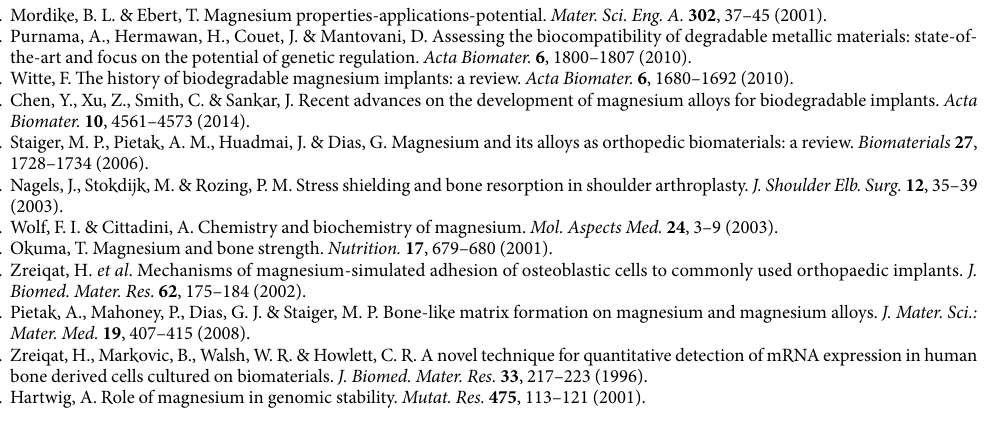
of the AZ61-AP, AP-HT and HT-SAM samples were characterized by low/variable vacuum scanning electron microscopy (LV-SEM, JSM-6390LV), equipped with an energy-dispersive X-ray spectrometer attachment (EDS, OXFORD/INCA 350). The static contact angle assessment was applied for wettability studies of the AZ61 Mg alloy with various surface treatments. All the samples were cleaned with absolute alcohol, dried in N 2 gas and the contact angles were measured using 10 μ l distilled water as the solvent. The electrochemical properties of AZ61, AZ61-AP, AP-HT and HT-SAM specimens were conducted by a Princeton Applied Research PARSTAT 2273 potentiostat. The cor- rosion cell used in this study was a three-electrode assembly, in which platinum sheet and Ag/AgCl were used as the counter electrode and the reference electrode, respectively. AZ61 alloy and different surface treated specimens were applied as the working electrode. The standard simulated body fluid (R-SBF) with a pH of 7.4 was prepared according to the Kokubo and Takadama’s recipe 48 in which the ions concentrations were similar to the human blood plasma, as listed in Table 3. The open-circuit potential (OCP) was measured in the corrosion cell that contained standard R-SBF solution. The measuring duration was 1500 s. Electrochemical impedance spectroscopy (EIS) measurements were per- formed from 10 5 to 10 –1 Hz, and the AC amplitude of the sinusoidal voltage signal was 10 mV. Prior to starting of the experiments, the specimens were immersed into the R-SBF solution for 30 min to stabilize the open-circuit potential. The EIS data measured at the established open-circuit potential were fitted with the Powersuite soft- ware, and the Nyquist and Bode plots were obtained from the analysis of the impedance data. The corrosion behaviors of AZ61, AZ61-AP, AP-HT and HT-SAM specimens within R-SBF at 37 °C were investigated by poten- tiodynamic polarization tests according to the ASTM G102-89. A three-electrode cell was used for potentiody- namic polarization tests. All experiments were carried out in the R-SBF at a constant scan rate of 0.5 mV/s. The anodic and cathodic polarization curves were obtained for each specimen. Corrosion current densities and cor- rosion potentials were determined from the potentiodynamic polarization curves by Tafel extrapolation methods.